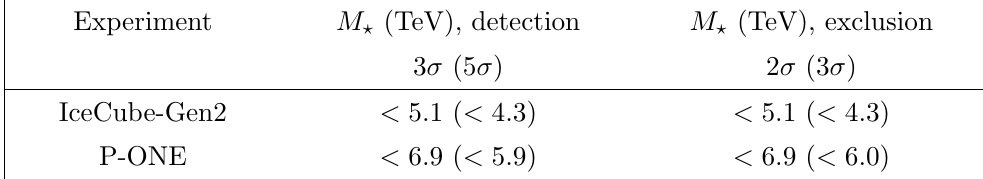
Table 4 . Projections for the 6-extra-dimension fundamental scale that can be detected or excluded with upcoming experiments. We consider detectors with the proposed properties of IceCube-Gen2 and P-ONE with 10 years of running time. See (cid:12)gure 10 for discovery limits and 11 for exclusion limits for a range of fundamental